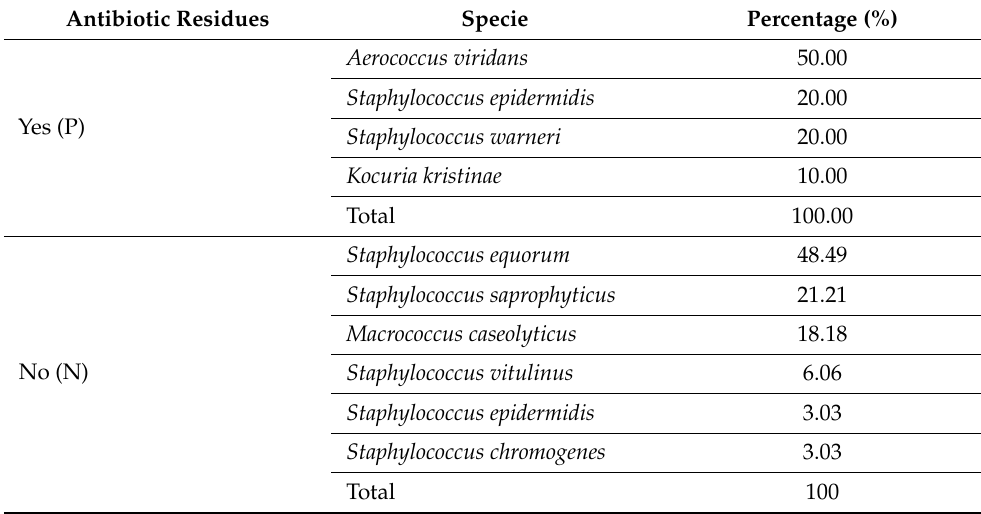
Table 4. Percentage of isolates identified in fresh goat meat from Mannitol Salta Agar. Samples with the presence of antibiotic residues (P) and free of antibiotic residues (N).